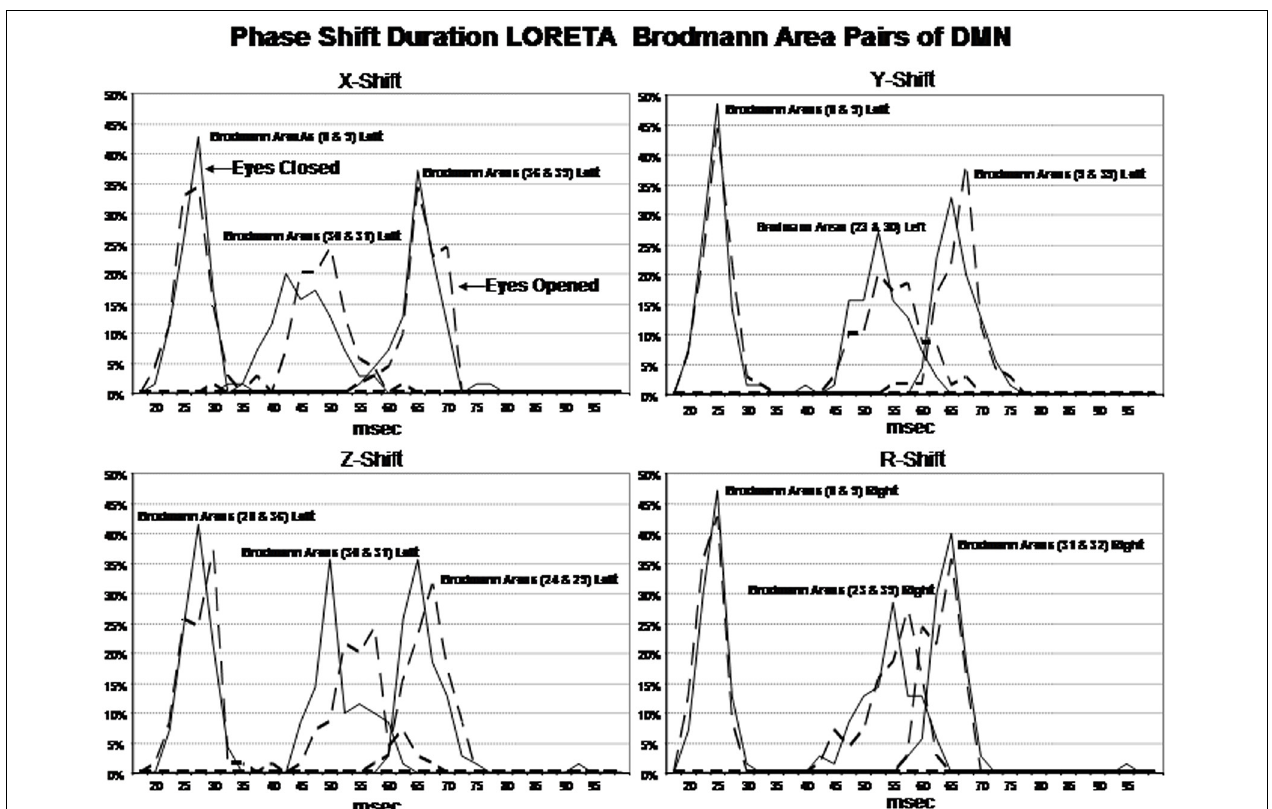
FIGURE 3 | Phase shift durations between Brodmann areas in the x, y, z LORETA time series directions and the resultant vector in the lower right (cid:2) x 2 + y + z 2 . The x-axis is phase shift duration in milliseconds where R = and the y-axis is the percent of subjects that exhibited a given phase shift duration for different Brodmann area pairs. The solid line is the eyes closed condition and the dashed line is the eyes open condition. All of the subjects